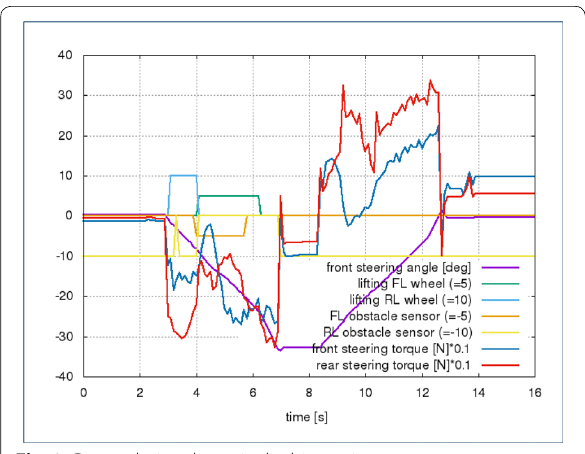
Fig. 8 Data 1 during the stair-climbing gait